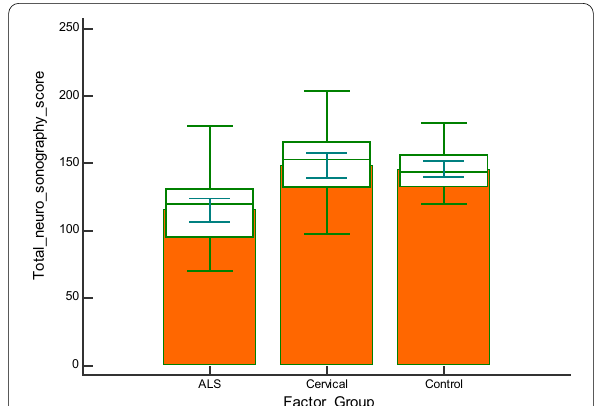
Fig. 5 Comparison between the three groups as regards total neuro‑sonography score